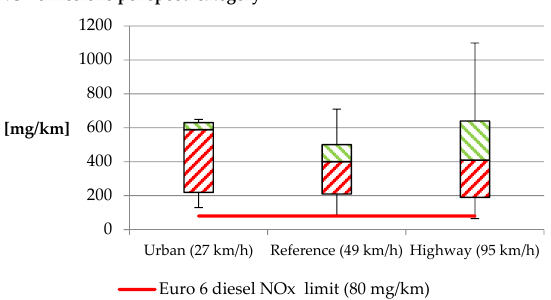
Figure 3. On ‐ road NO x emission boxplot results for Euro 6 diesel passenger cars according to speed category (based on [42]). Important for this article are the NO x emissions at urban speeds, which range from 130 to 650 mg ∙ km − 1 , despite the type ‐ approval limit of 80 mg ∙ km − 1 for Euro 6 diesel cars.